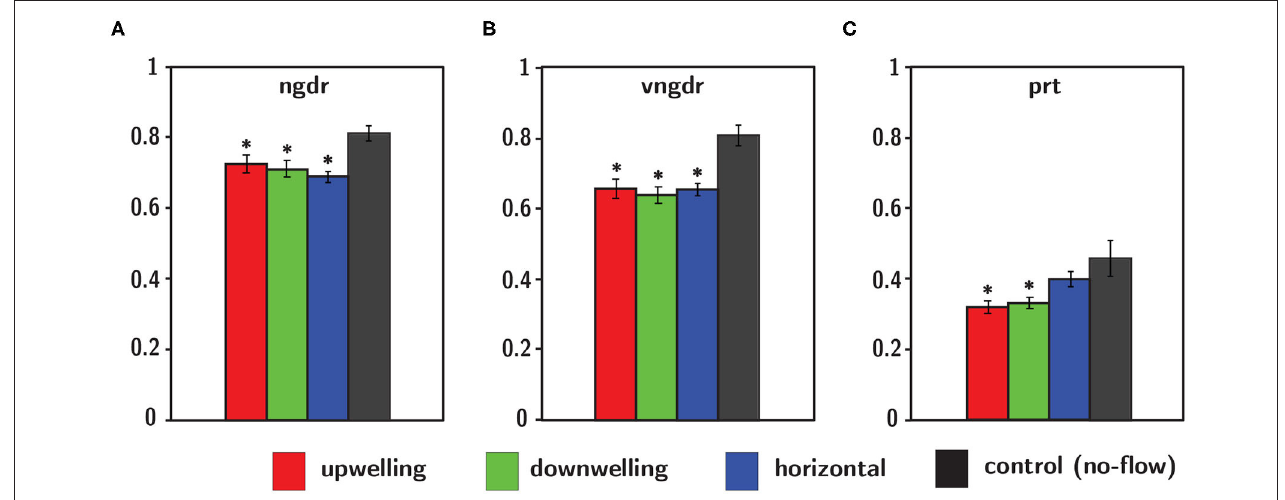
FIGURE 12 | Gross path parameters including (A) net-to-gross-displacement ratio ngdr , (B) vertical net-to-gross-displacement ratio vngdr , and (C) proportional residence time prt for upwelling (red), downwelling (green), and horizontal (blue) shear flow orientations in addition to the no-flow condition (black). Error bars span ± one standard error. ∗ Indicates statistical significance ( p < 0.05) of shear flow values relative to the no-flow condition.